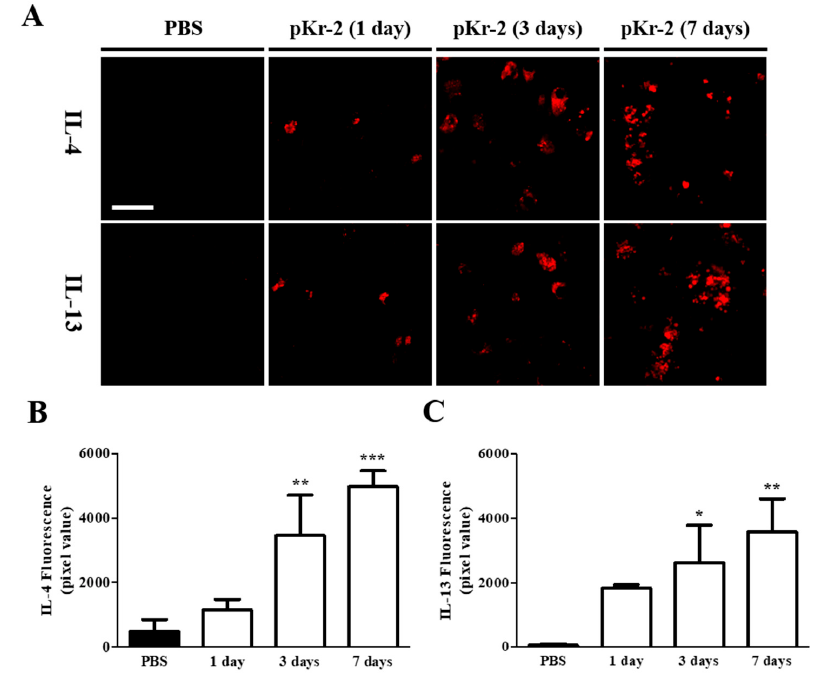
Figure 2. Intracortical injection of pKr-2 induces an increase of Interleukin-4 (IL-4) and Interleukin-13 (IL-13) expression in vivo. Cerebral cortical tissue sections, adjacent to those used in Figure 1 were immunostained with IL-4 and IL-13. ( A ) Fluorescence images of IL-4 and IL-13, and ( B , C ) quantification in the cerebral cortex using Image J at the indicated time points. Error bars represent the mean ± SEM. * p < 0.05, ** p < 0.01, *** p < 0.001 as compared with control according to One way ANOVA and Newman–Keuls analyses. Scale bar, 40 µ m; n = 3 to 6.